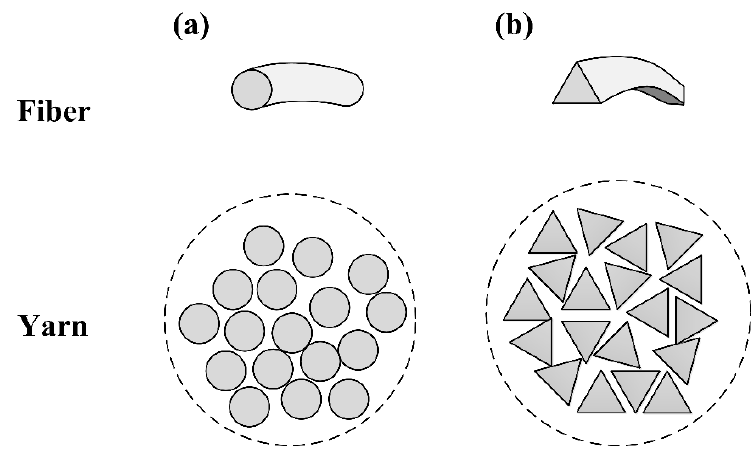
Figure 5. The fibers in the fabric are sketched, including ( a ) circular and ( b ) triangular shapes. The simulations and analyses are performed for the cases of a single fiber to an aggregate of fibers (e.g.,